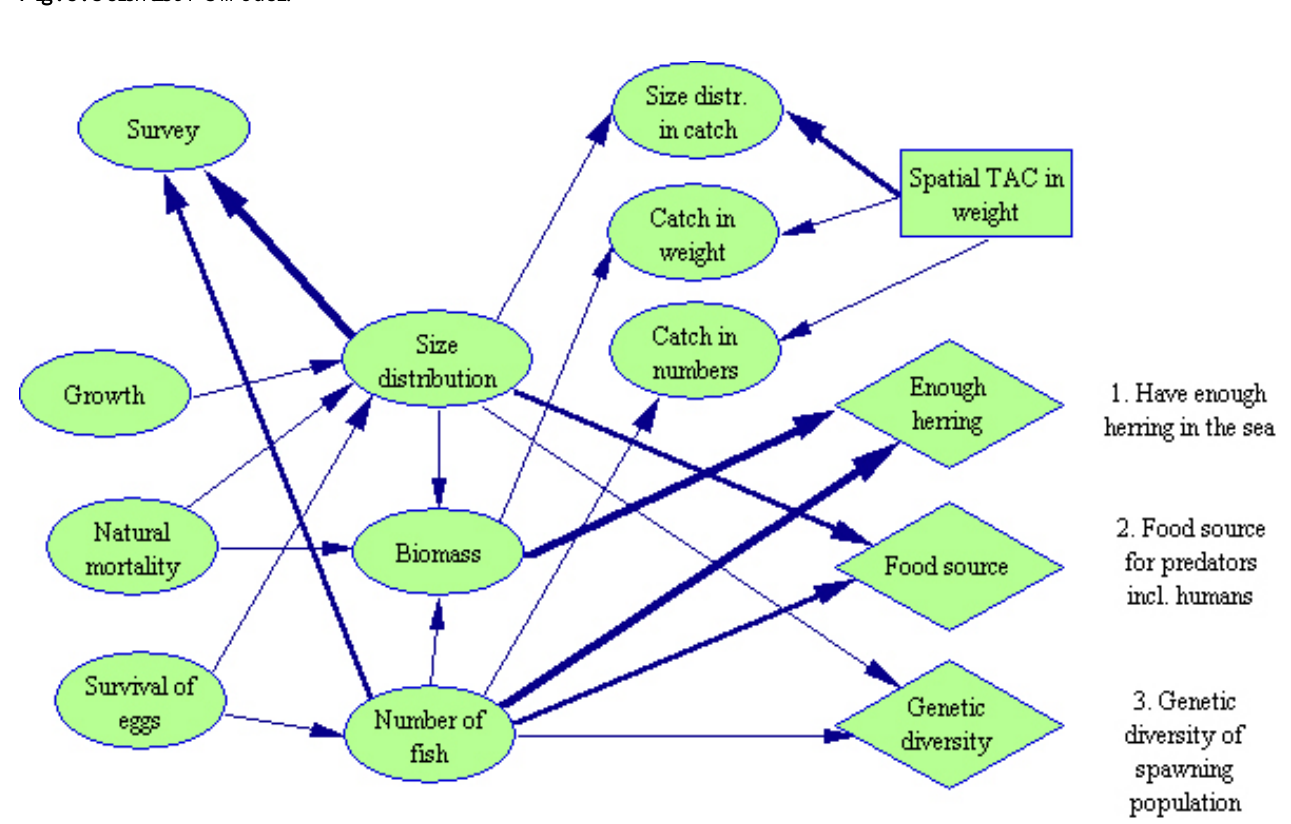
Fig. 5. Scientist 1’s